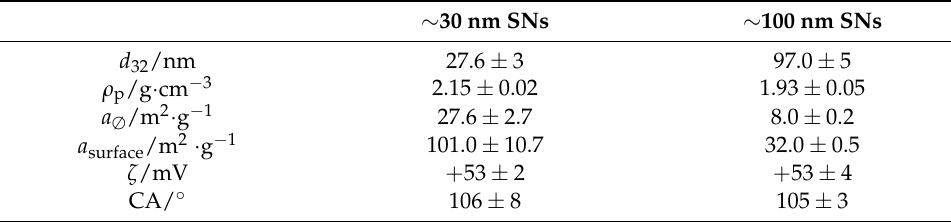
Table 1. Characterization of the applied SNs. The particles differ in size but are very similar regarding charge and hydrophobicity. ( d 32 Sauter mean diameter of the particles (TEM), ρ p single particle density, a ∅ specific particle cross-section, a surface specific particle surface area, ζ zeta-potential in ethanol, CA contact angle against water.)